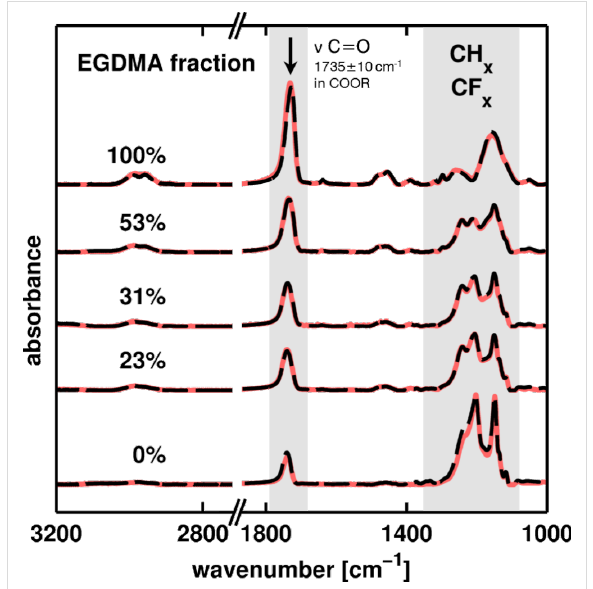
Figure 2: FTIR spectra of p-PFDA films with different EGDMA cross- linker ratios in the as-prepared state (dashed line) and after heat-treat- ment (solid line). The signal intensity is normalized by the film thick- ness. Data are shifted on the y -axis for clarity.